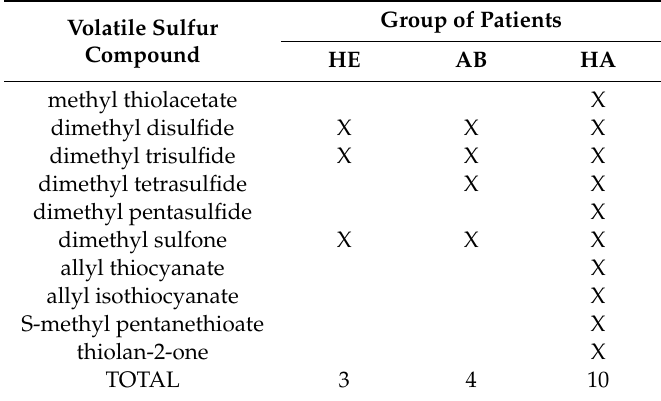
Table 1. List of volatile sulfur compounds detected in incubated salivary samples from healthy patients (HE) and subjects with submandibular abscesses (AB) and halitosis (HA); “X” means the presence of the